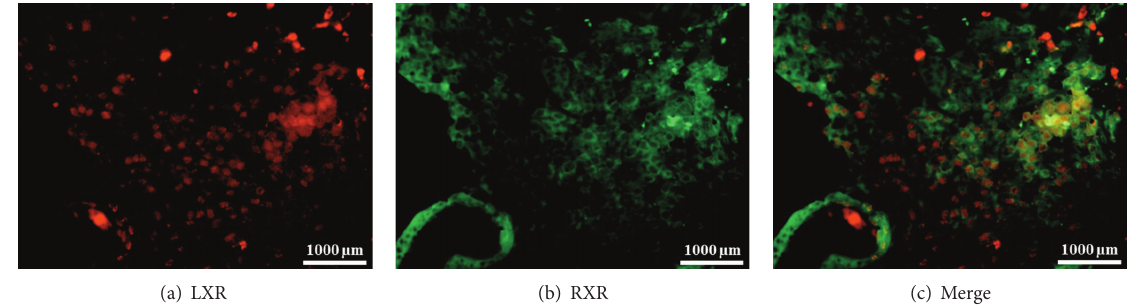
Figure 6: Analysis of LXR and RXR 𝛼 coexpression in extravillous trophoblast cells (EVT) of abortive tissue. LXR expression is shown in red (a). RXR 𝛼 expression is visualized in green (b). Synchronized expression of both nuclear receptors in EVT is shown in (c). The same expression scheme was identified in normal control